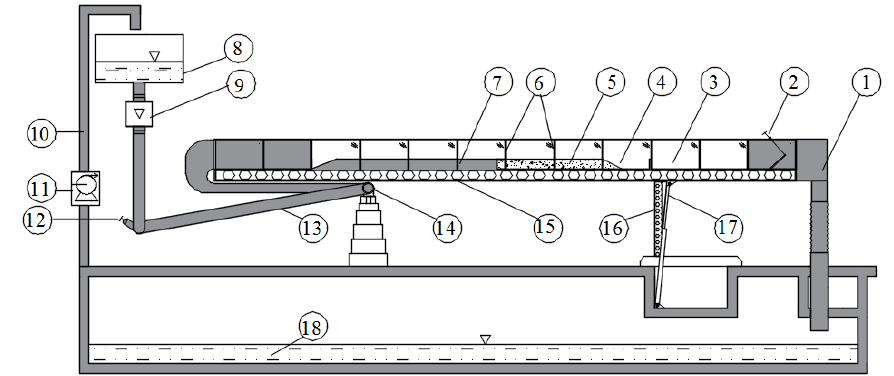
Figure 3. Experimental channel scheme—side view. Where: 1—chute chamber; 2—the regulatory gate; 3—glass side wall; 4—collection chamber; 5—sandy bed; 6—supports for side walls; 7—solid bottom; 8—upper reservoir; 9—electromagnetic flow meter; 10—a pipeline conducting water; 11—the pump; 12—the regulatory valve; 13—the feeding pipeline; 14—the support with joint; 15—the support plate of the channel; 16—the support with adjustable frame elevation; 17—the hydraulic cylinder; 18—the lower reservoir.